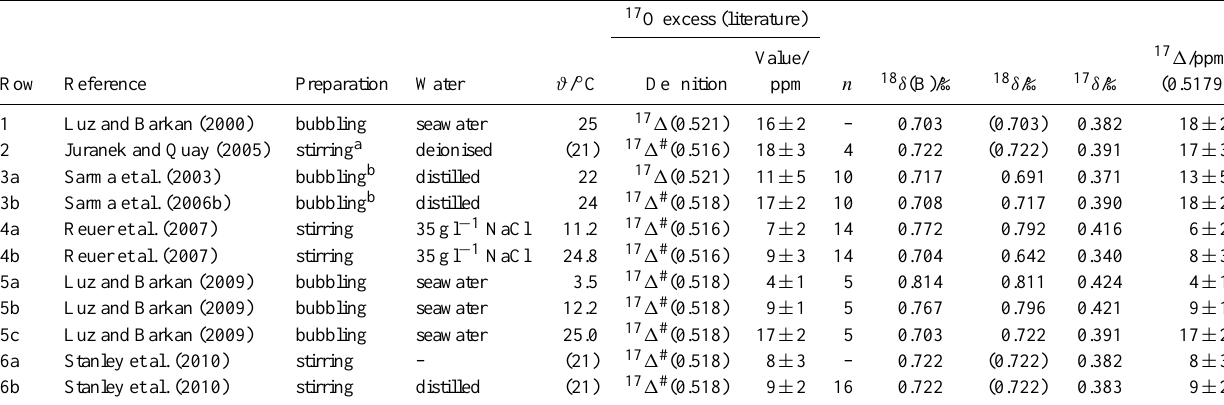
Table 1. Triple oxygen isotope composition of dissolved O 2 at saturation with atmospheric air reported in the literature. Most samples were analysed by headspace equilibration, except row 3b (analysed by membrane extraction). 18 δ (B) is 18 δ at saturation according to Benson et al. (1979). The last column corresponds to the recalculated 17 O excess using the definition given by Eq. (8). Uncertainties are ± 1 standard error. n = number of measurements. A value in brackets has not been reported and was assumed. A dash (–) means that the corresponding parameter was not reported.